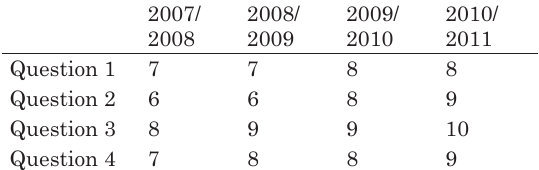
Table 2. The answers of one respondent (as exampled from 114 respondents) to the questions related to the formula for happiness